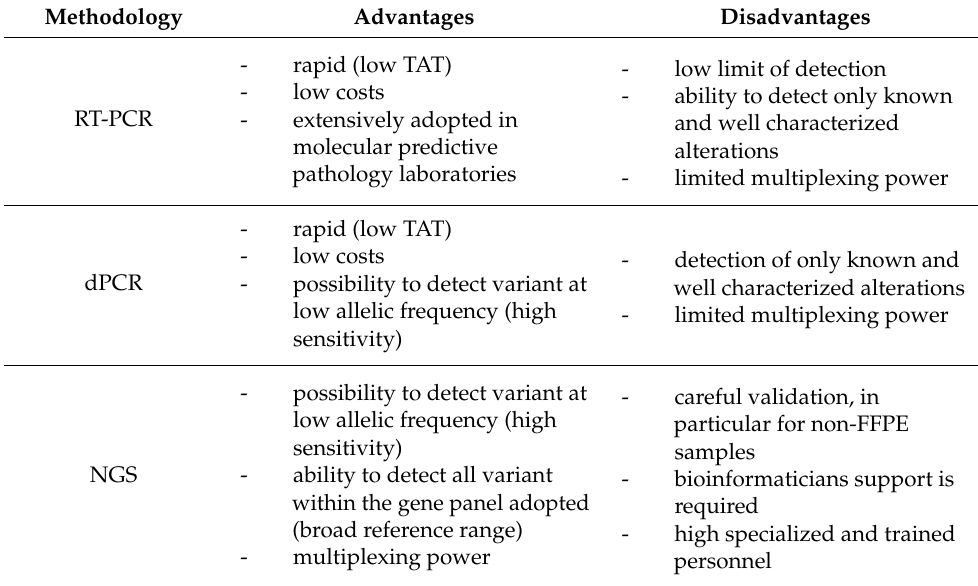
Table 2. Advantages and disadvantages of the main molecular techniques.